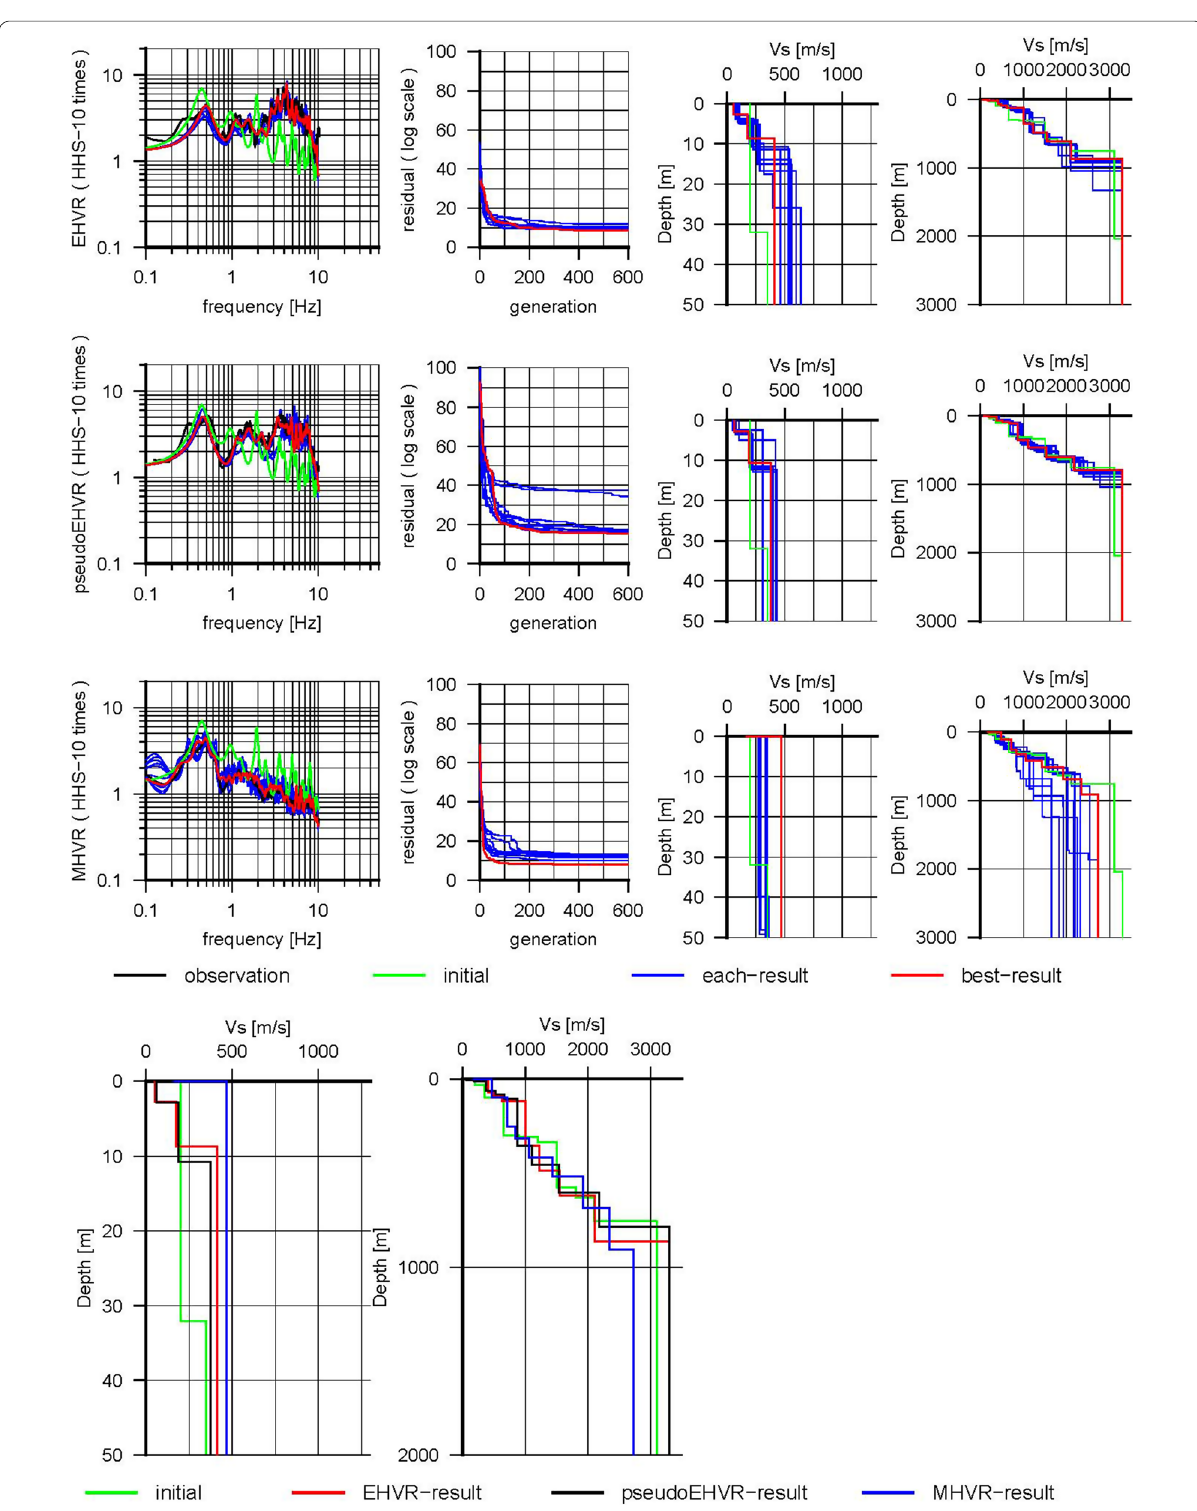
Fig. 22 Inversion results at MYG015 when an underground structure model based only on the J-SHIS information is used (i.e., no constraint in the shallow